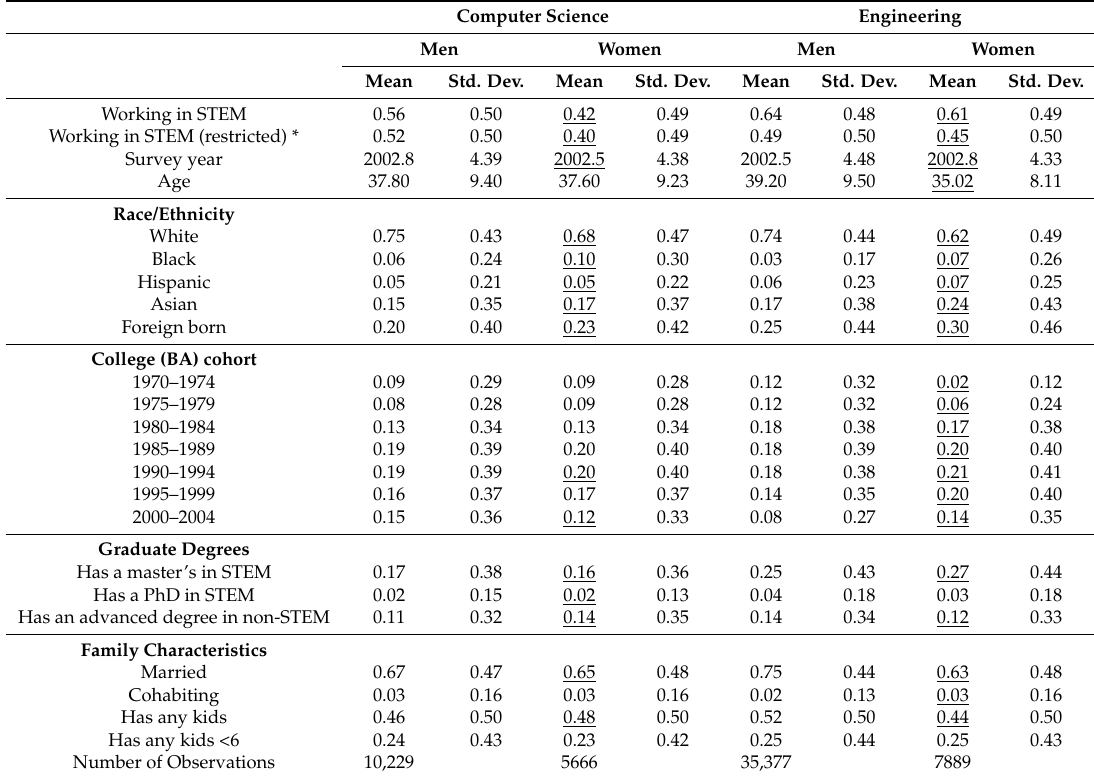
Table 1. Descriptive Statistics of those who majored in Computer Science or Engineering, by